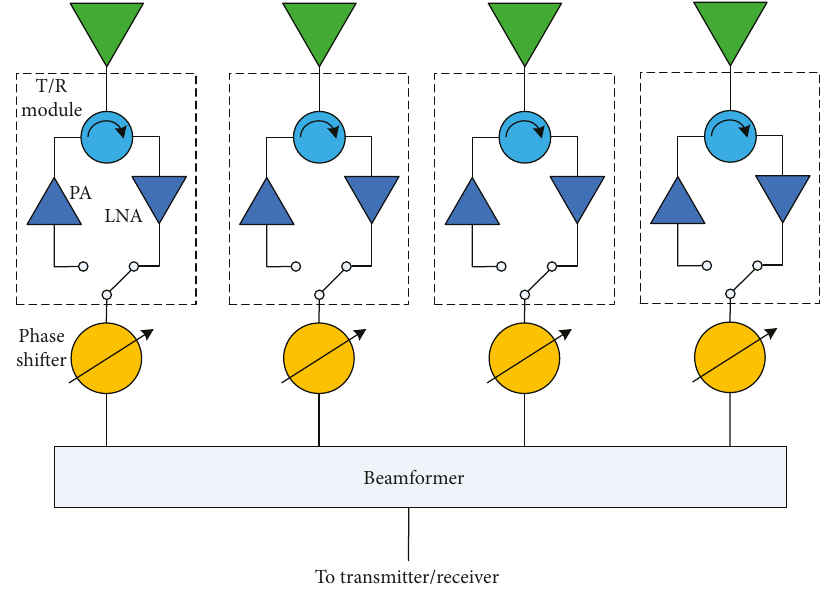
Figure 1: Typical architecture of an active phased antenna